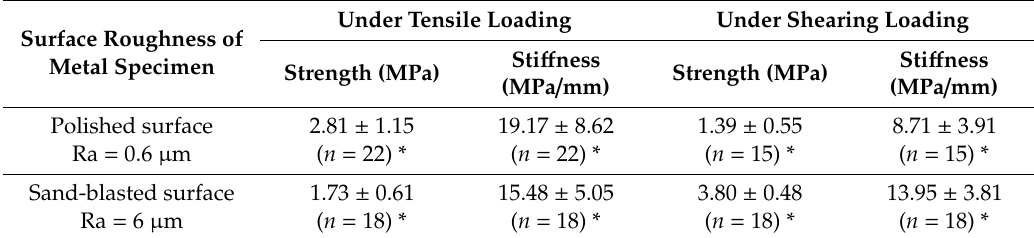
Table 1. Interface tensile strength and bonding stiffness for cement/metal specimens.